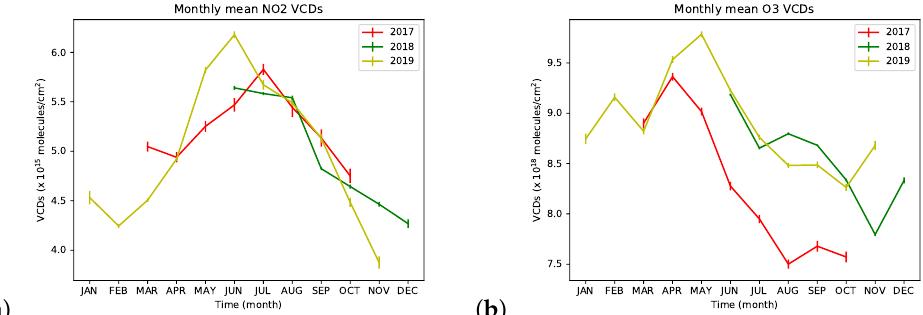
Figure 12. Monthly variability of NO 2 VCDs ( a ) and O 3 VCDs ( b ) in the three analyzed years. The error bars represent the standard deviations of the monthly mean